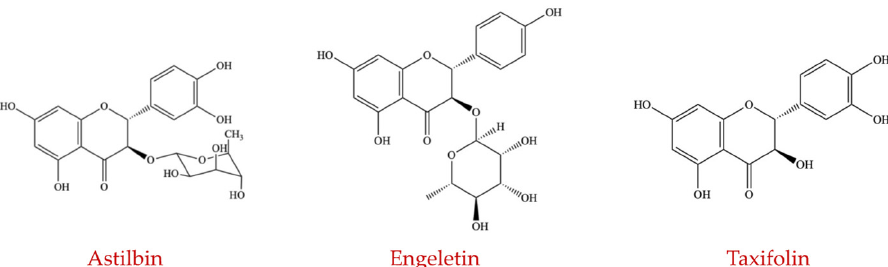
Figure 8. Chemical structures of flavanonols (astilbin, engeletin, and taxifolin) (self-generated). Isoflavones